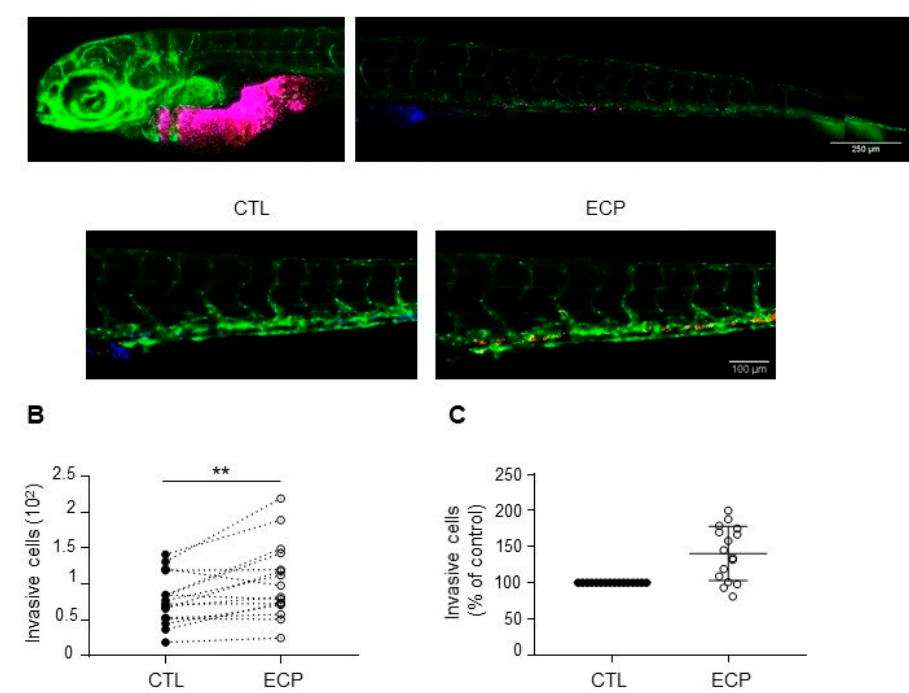
Figure 2. Invasion of MDA-MB-231 cells in xenografted zebrafish embryo. Equal quantities of control and persistent cells were mixed and then co-injected into in the yolk sac of zebrafish embryos before confocal analyses at 3 days post-injection as described in materials and methods. ( A ) Images of embryos at 3 days post-injection. Top panel shows merged images of control (blue) and persistent cells (red) at the injected site and in the tail of an embryo. Scale bar is 500 µm. Bottom panel shows separate images of control (blue) or persistent cells (red) in an embryo tail. Scale bar is 100 µm. Pictures were taken under a Zeiss confocal microscope (10×). ( B ) Graphic showing the number of invasive cells (persistent cells vs. control) in each zebrafish embryo ( n = 16). ( C ) Relative quantification of invasion. Invasion of persistent dells was expressed as the percent of control cells in each embryo ( n = 16). Illustrations and quantitative graphics are representative of 2 independent experiments, with 16 zebrafish embryos analyzed in each experiment. **, p < 0.01. Paired Student t -test.